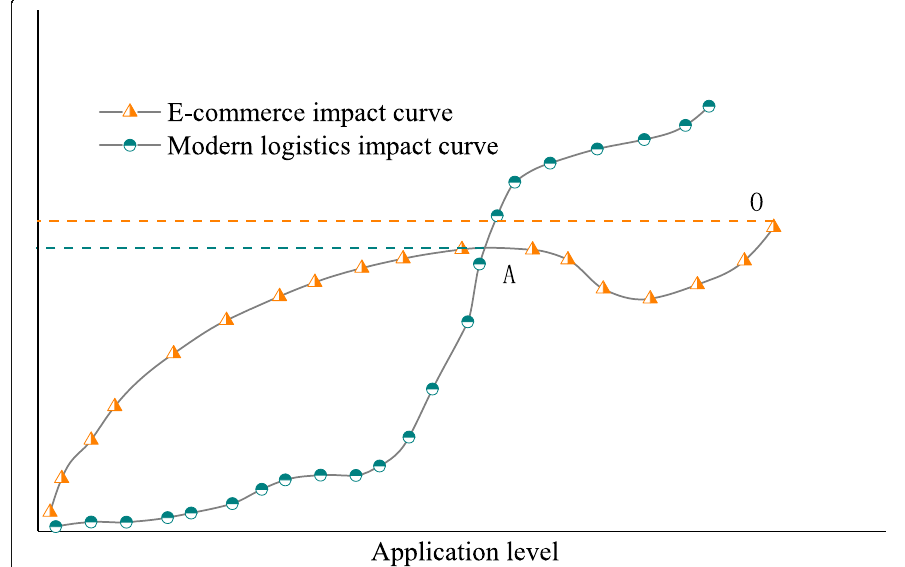
Fig. 3 The impact of the degree of application of e-commerce and modern logistics on the scope of regional economic